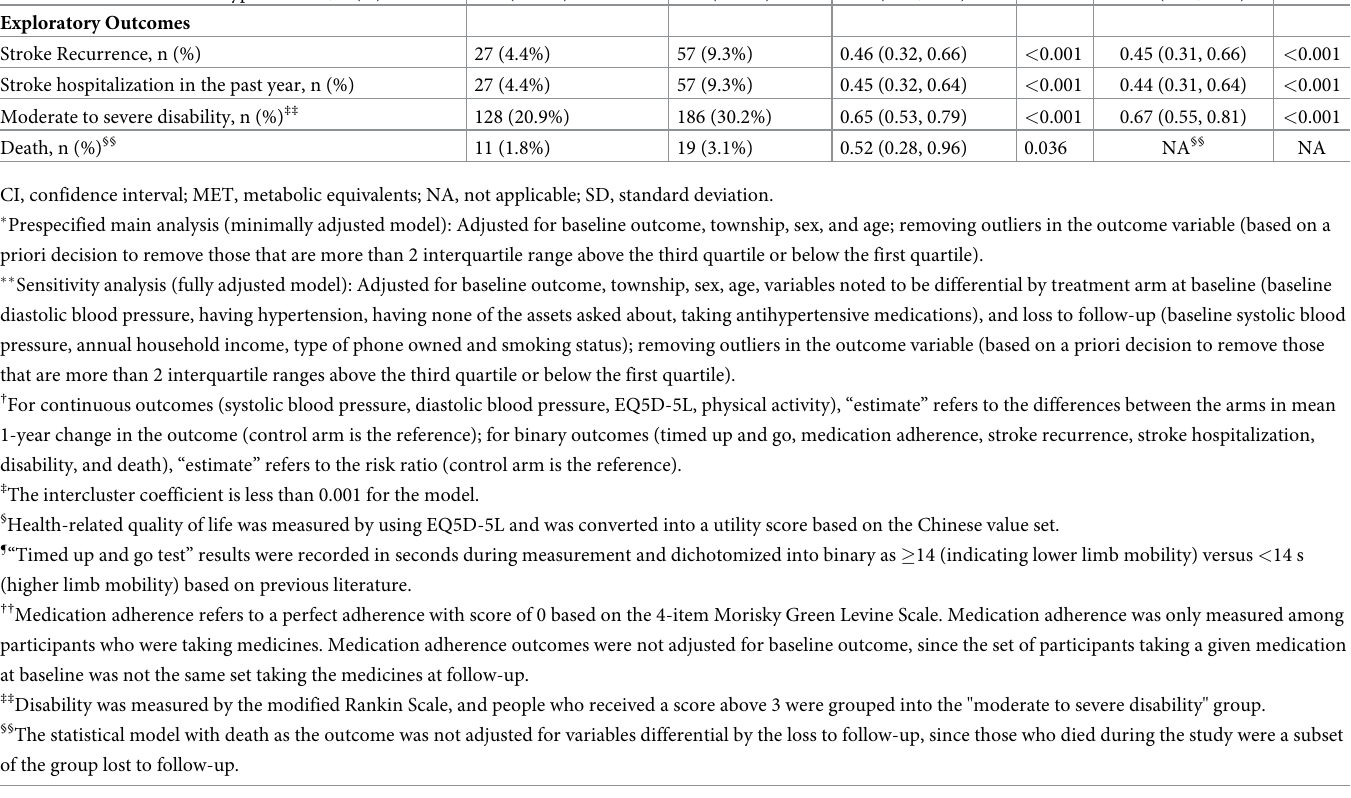
[RD] = 4.9 percentage points [pp]), hospitalization (4.4% versus 9.3%; RR = 0.45, 95% CI 0.32, 0.62; RD = 4.9 pp), disability (20.9% versus 30.2%; RR = 0.65, 95% CI 0.53, 0.79; RD = 9.3 pp), and death (1.8% versus 3.1%; RR = 0.52, 95% CI 0.28, 0.96; RD = 1.3 pp. Results were consis- tent in 3 additional sets of sensitivity analyses ( S6 Table ).